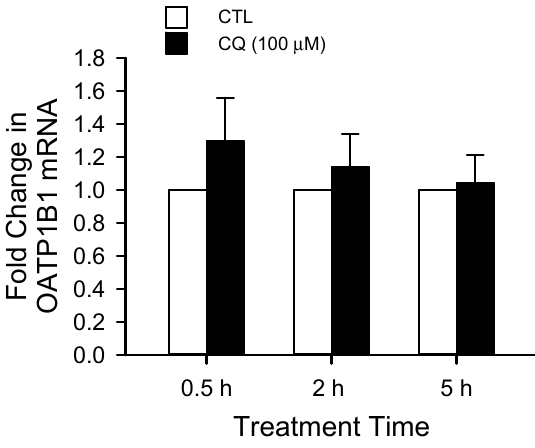
Figure 1. Chloroquine treatment did not affect OATP1B1 (organic anion transporting polypeptides 1B1) mRNA levels in HEK293-OATP1B1 cells. Model-estimated fold change and associated SE in OATP1B1 mRNA levels vs. control are shown at each treatment time. HEK293-OATP1B1 cells were treated with 100 μ M chloroquine (CQ) or vehicle control (CTL) for 5 h. OATP1B1 mRNA levels were determined by TaqMan ® real-time RT-PCR. OATP1B1 expression relative to that of control was analyzed with the 2 −ΔΔ C t method [163] using GAPDH as an internal control. The TaqMan ® probe and primer sequences (5 ′ –3 ′ ) used for human OATP1B1 were TCCTACATGACCCACGTGTGCCACA (probe), (forward CAAGTAGACCCTTGAAAATGATGT (reverse primer). Sequences used for human GAPDH were CAAGCTTCCCGTTCTCAGCC (probe), ACCTCAACTACATGGTTTAC (forward primer) and GAAGATGGTGATGGGATTTC (reverse primer). A generalized linear mixed model with the log link function, a fixed group effect (CQ vs. CTL) and a random experiment effect (experiment date) was fit to the data ( n = 3 in triplicate), allowing for group-specific over-dispersion. Statistical analysis was conducted using the SAS software (version 9.3, Cary, NC, USA).